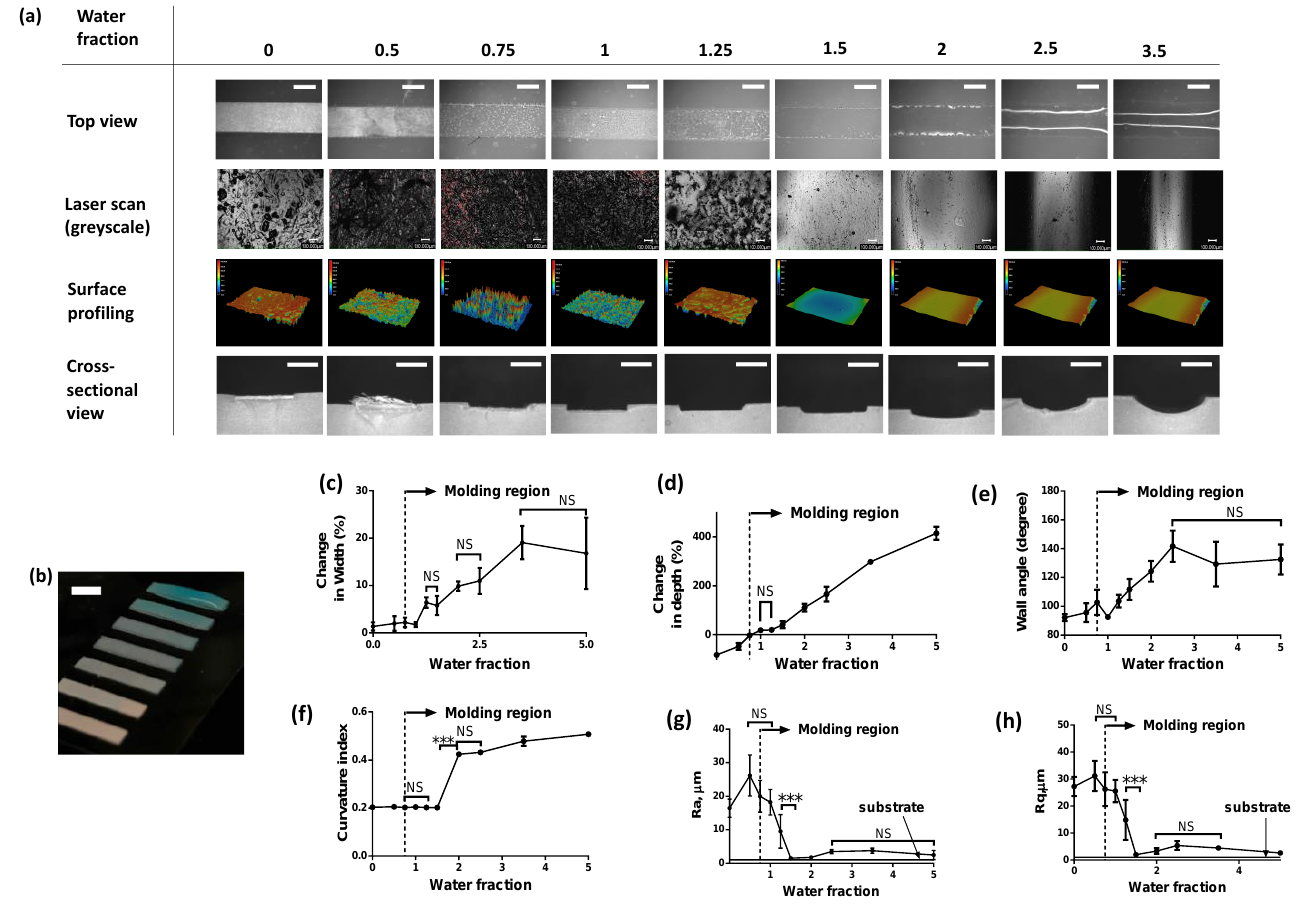
Figure 5. Effect of mold water content on the replica molding process. ( a ) Images and laser scans showing the effect of progressively increasing the water fraction of a mold. A minimum water fraction of 0.75 was needed to commence the molding process. The scale bars for top view and cross-sectional images are 1 mm. The scale bar for the laser scan grey scale images is 100 µm. ( b ) Image showing how the dry paper mold appears upon progressive addition of water. The scale bar on the image is equivalent to 2 mm. Even beyond the saturation point, the excess water is retained on the mold since the bottom substrate is hydrophobic. Characterization plots can be seen showing the effect of increasing water fraction on the channel width ( c ), on the channel depth ( d ), the wall angel ( e ) and curvature index ( f ). Additionally, the effect of water fraction on the resulting channel roughness was evaluated by measuring the gold standard roughness parameters, Ra and Rq as seen in ( g ) and ( h ). NS represent non-significant groups for which p > 0.05 whereas rest of the measurements were found statistically significant based on unpaired t -test and yielded a p < 0.001 denoted by ***.